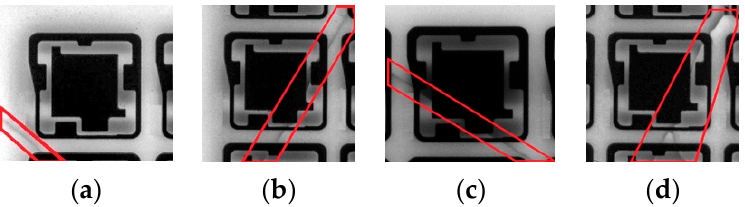
Figure 1. Defects in chipset at various positions on a substrate. ( a ) In the corner, ( b ) and ( c ) on borders, and ( d ) in the middle.